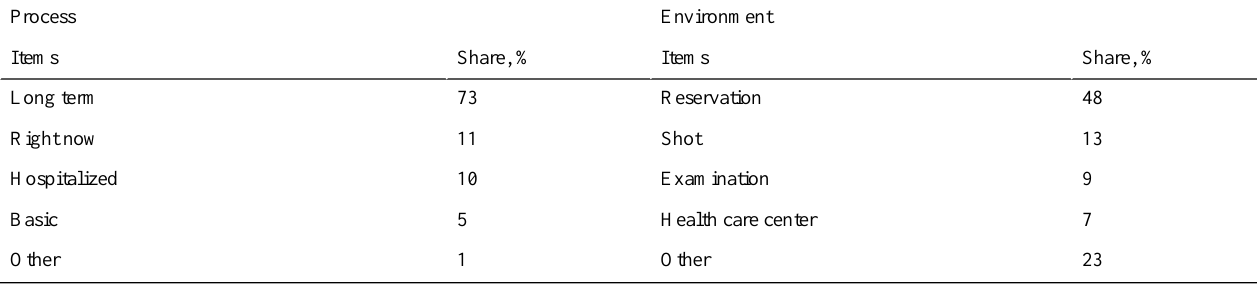
Table 4. In-depth analysis of negative attitude in 2009.